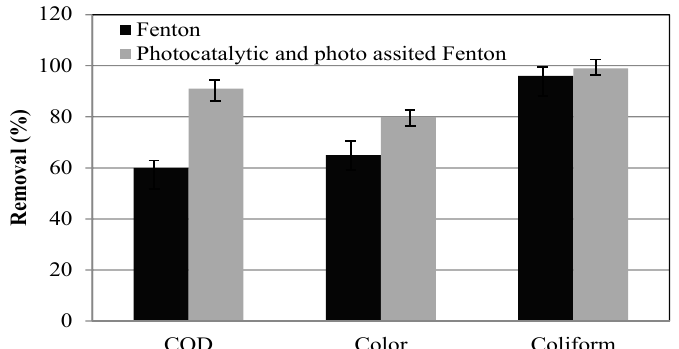
Figure 12. Comparison of COD, color, and coliform removal efficiency between Fenton and photo-assisted Fenton under optimal condition.